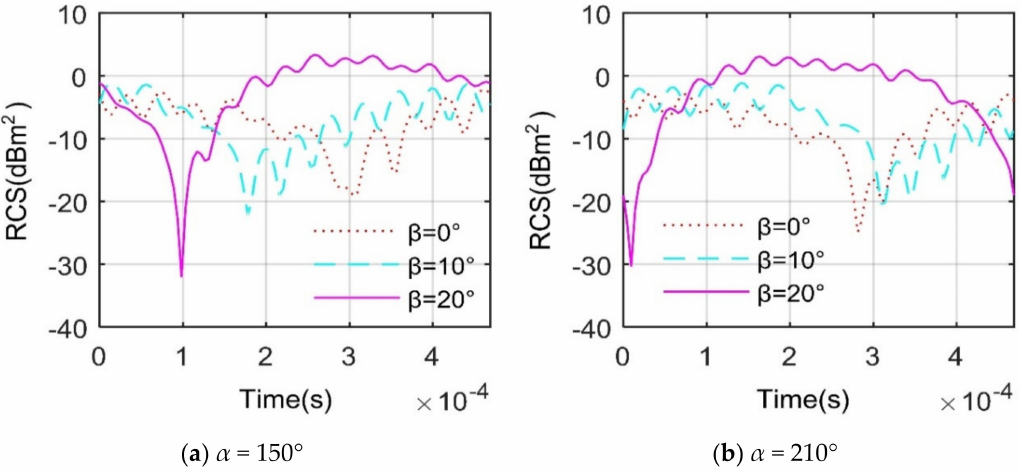
Figure 13. Influence of elevation angle on dynamic RCS of m low , N obs,low = 1 and β = (0, 10, 20) ◦